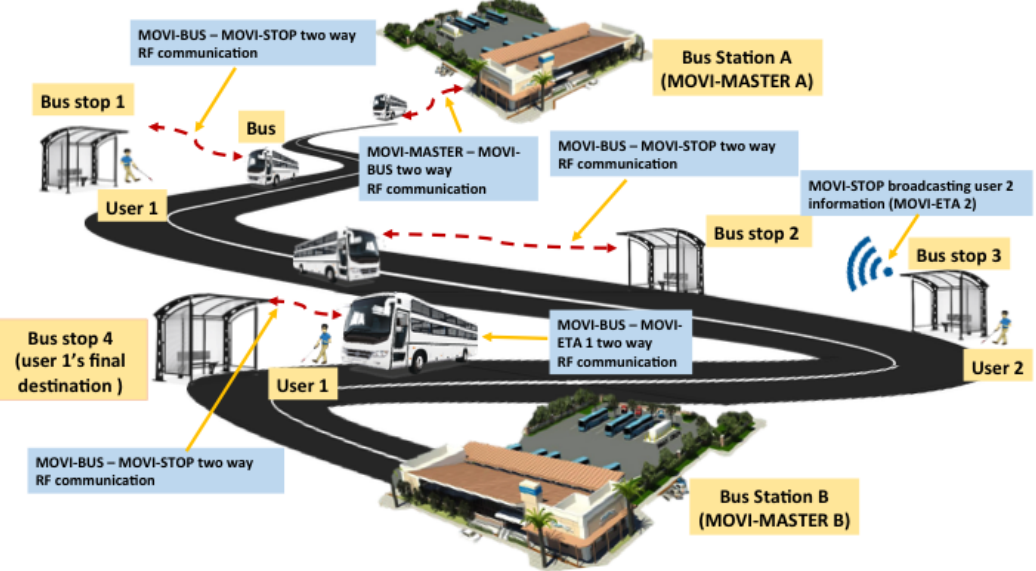
Figure 1. MOVIDIS conceptual working